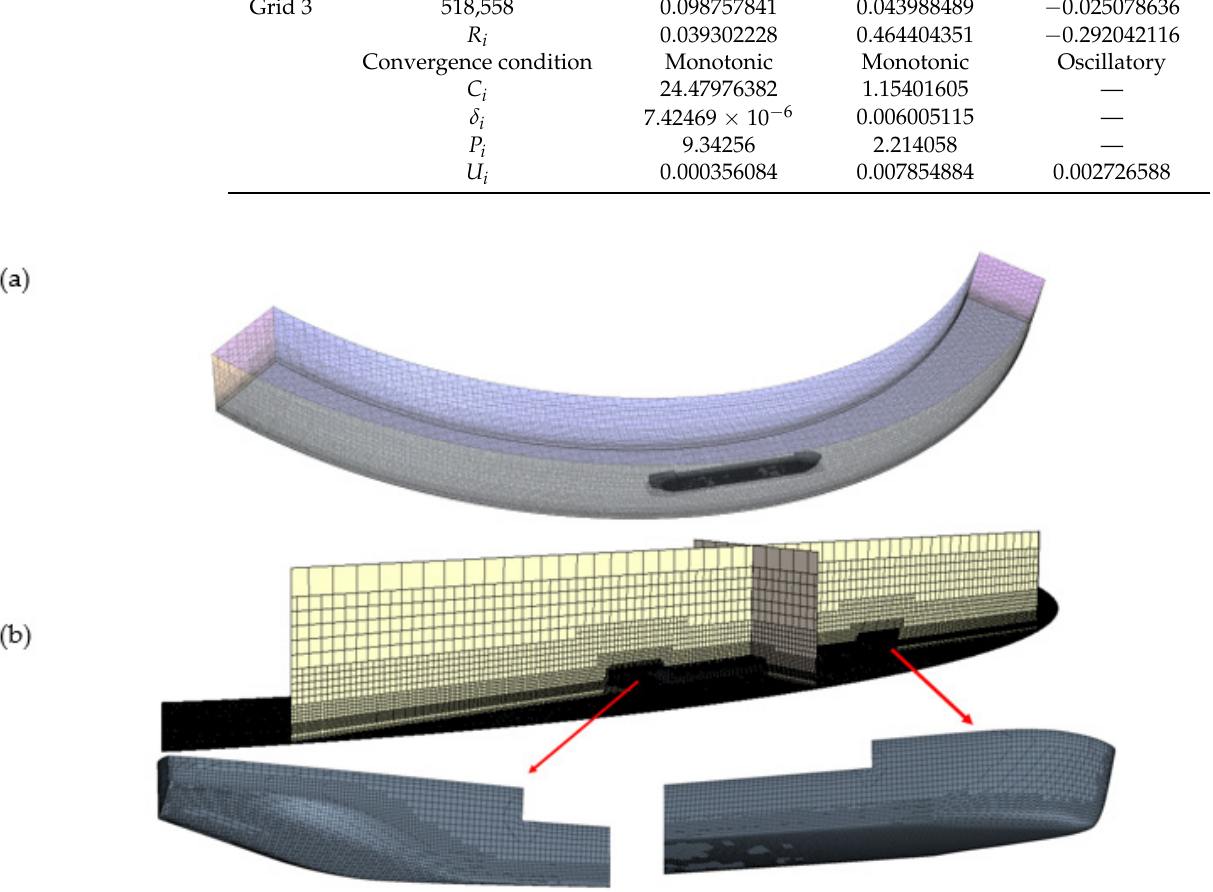
Figure 4. Mesh scene of the computational domain (R = 17.72 m). ( a ) Volume mesh scene of the entire computational domain; ( b ) Volume mesh scene inside the computational